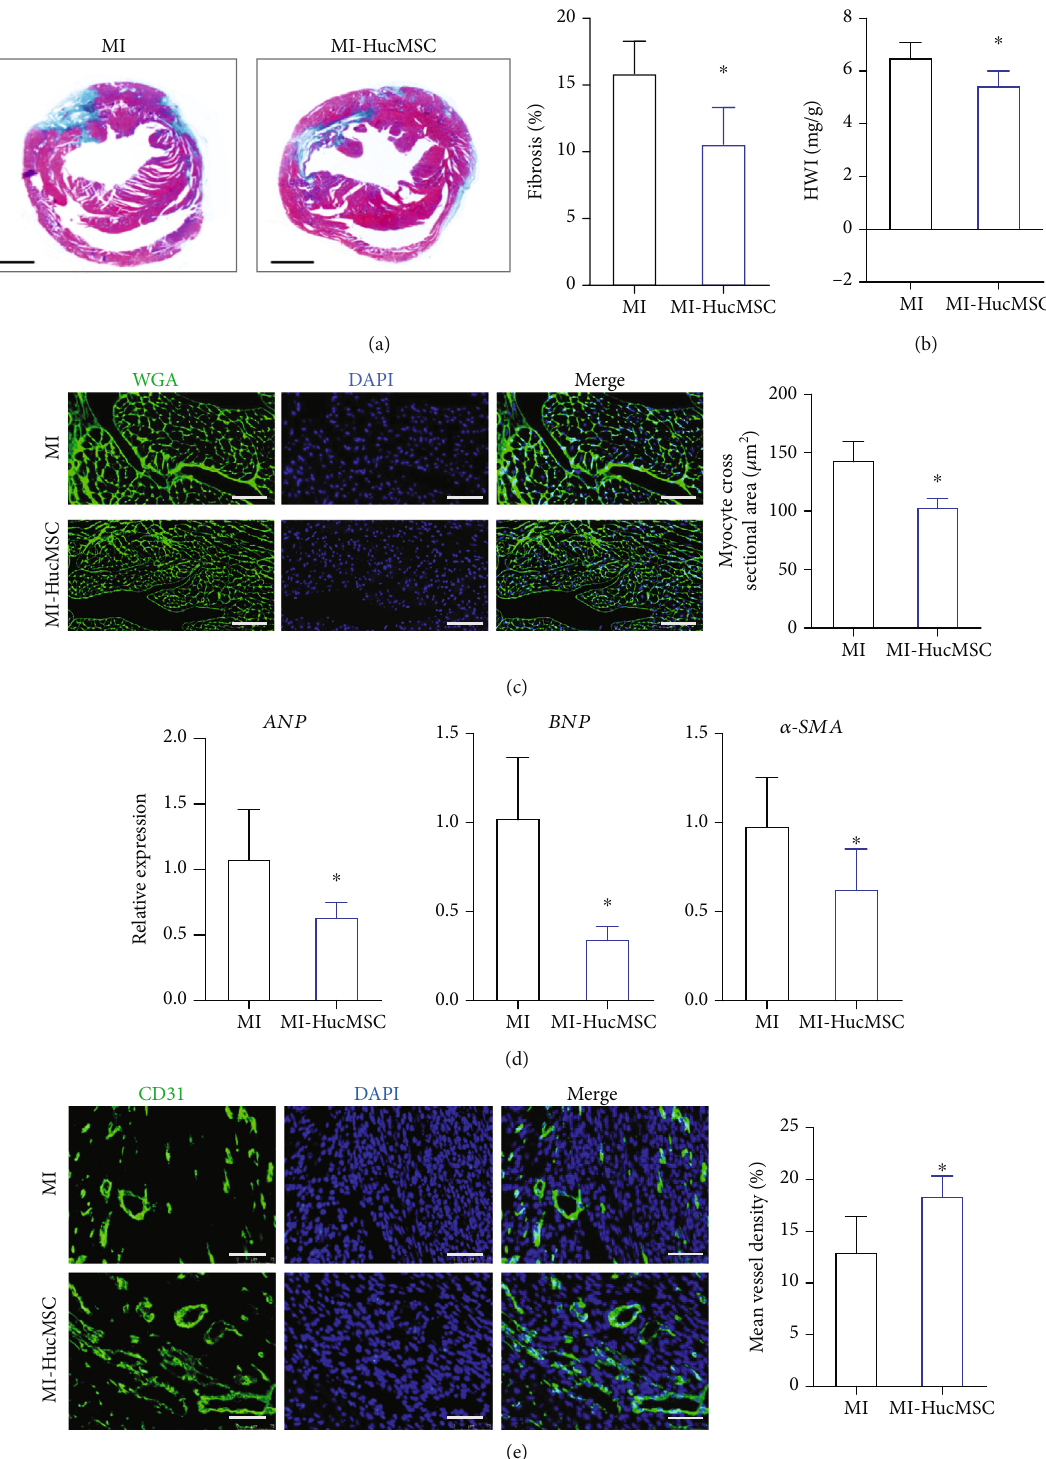
Figure 2: Iv-administered HucMSC prevented adverse cardiac remodeling after MI. (a) Representative images of Masson ’ s trichrome staining and quantitative analysis of fi brosis percentage at 28 days after MI and HucMSC injection. Scale bar = 1000 μ m. (b) Heart weight (milligrams) to body weight (grams) ratio (HWI) at 28-day post-MI. (c) Representative images of WGA staining and quantitative analysis of cardiomyocyte CSA. Scale bar = 75 μ m. (d) qRT-PCR measurement of ANP , BNP , and α -SMA at 28-day post-MI. (e) Representative images and quantitative analysis of CD31 staining at 28-day post-MI. Scale bar = 75 μ m. WGA: wheat germ agglutinin; CSA: cross-sectional area. n = 5~ 6 mice for each group. ∗ p < 0 : 05 vs. MI